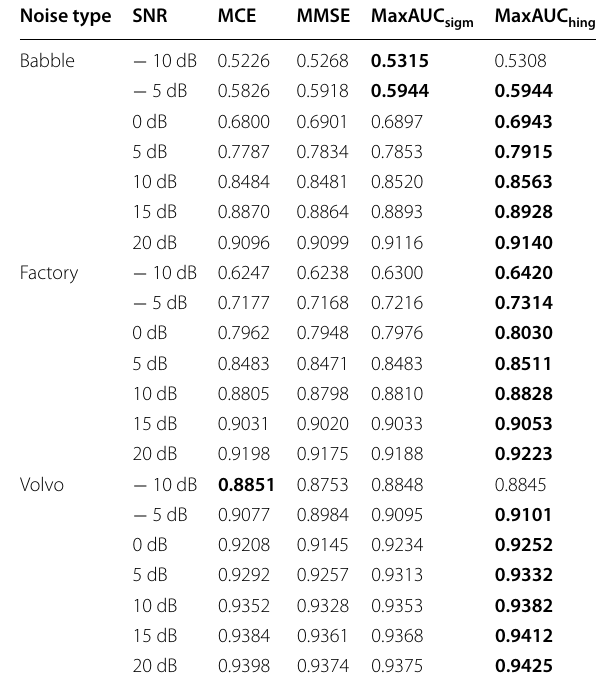
Table 3 AUC results of the comparison VADs with the BLSTM model and STFT acoustic feature on the English Noisy‑CHiME‑4 test dataset